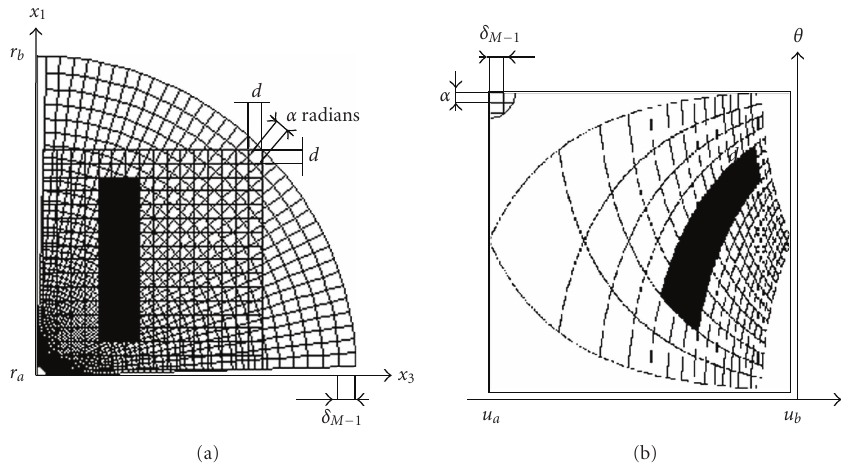
Figure 4: The retinocortical sampling interface. (a) The exp-polar sampling (the distance between circles displayed in the first quadrant changes exponentially) of a bar pattern. (b) The bar pattern in the cortical coordinates rendered by the inverse DPFT computed with FFT. The cortical uniform sampling grid, obtained by applying the complex logarithm to the exp-polar grid in (a), is shown in the upper left